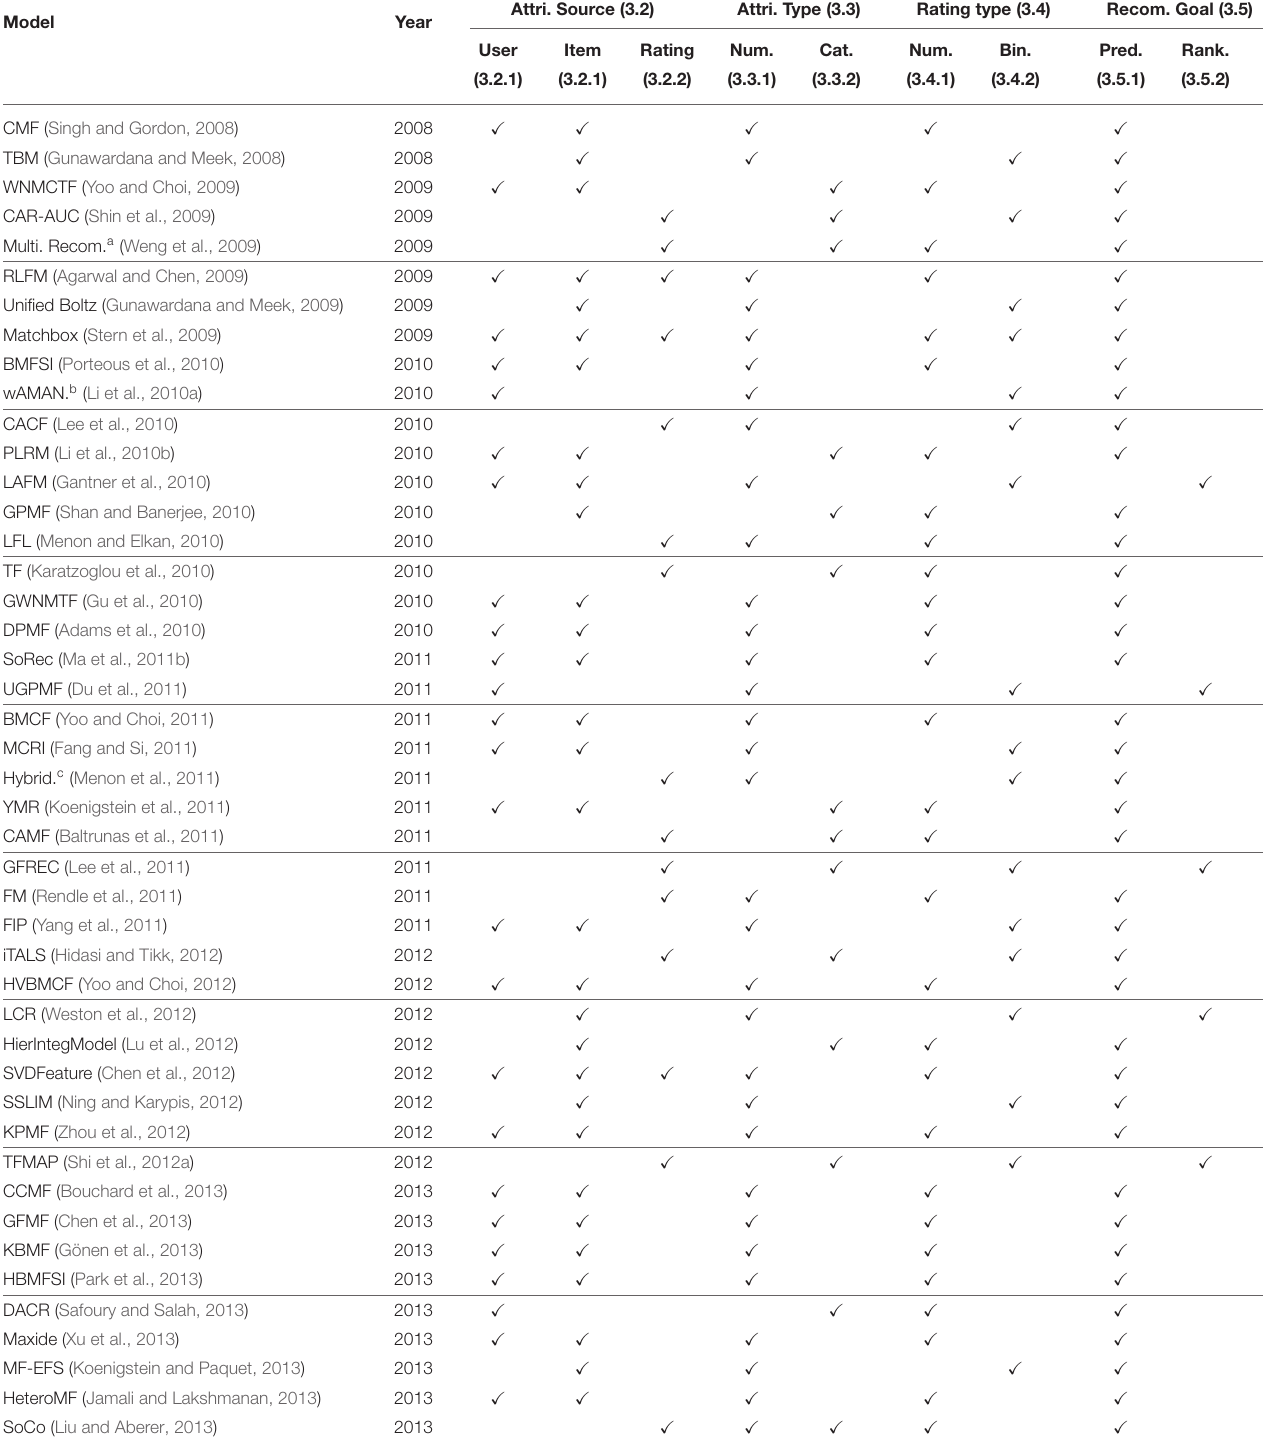
TABLE 2 | List of model